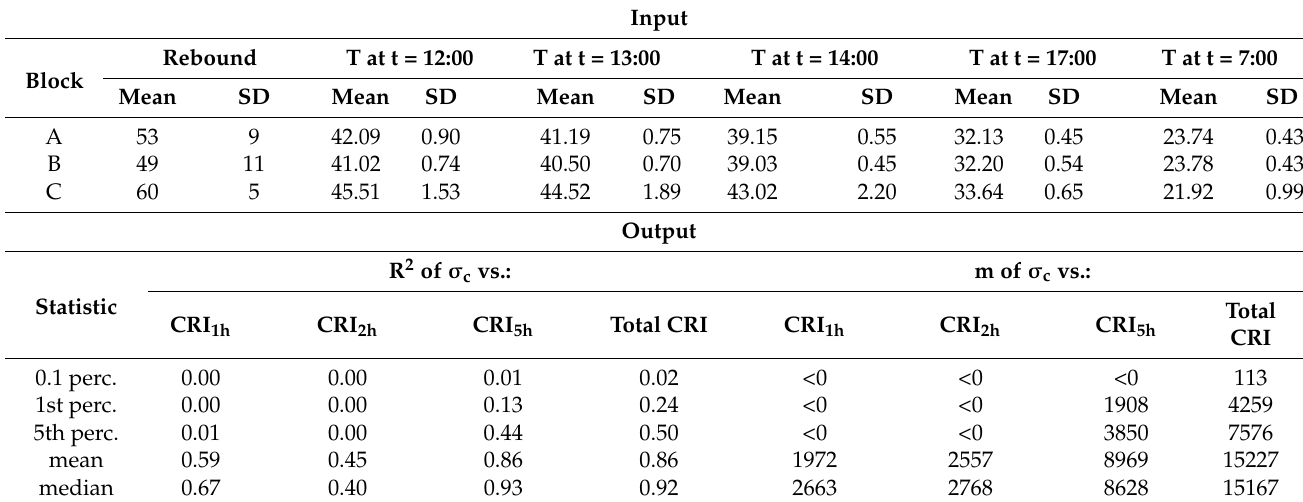
Table 3. Input and output of a Monte-Carlo simulation (10,000 independent repetitions) to assess correlations between rebound number-derived compressive strength and cooling rate indices with different time spans. R 2 and m are the coefficient of determination and the slope of the linear regression between σ c and CRI (i.e., σ c = m · CRI + q); perc. =